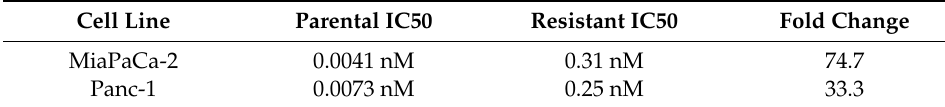
Table 1. Di ff erences between IC50 values of nab-paclitaxel in parental and resistant MiaPaCa-2 and Panc-1